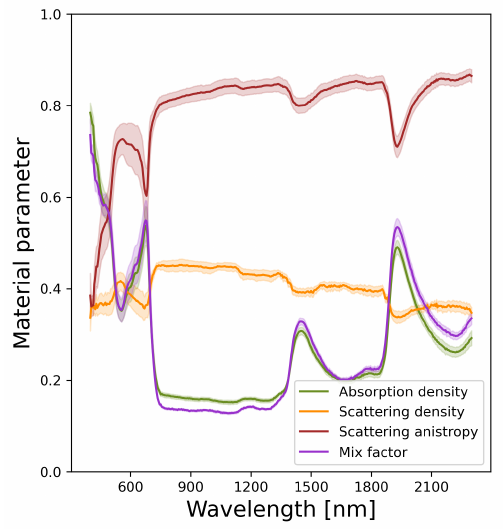
Figure 6. Mean leaf material parameters of the 28 simulations (solid lines). Standard deviation of parameter values are indicated by colored